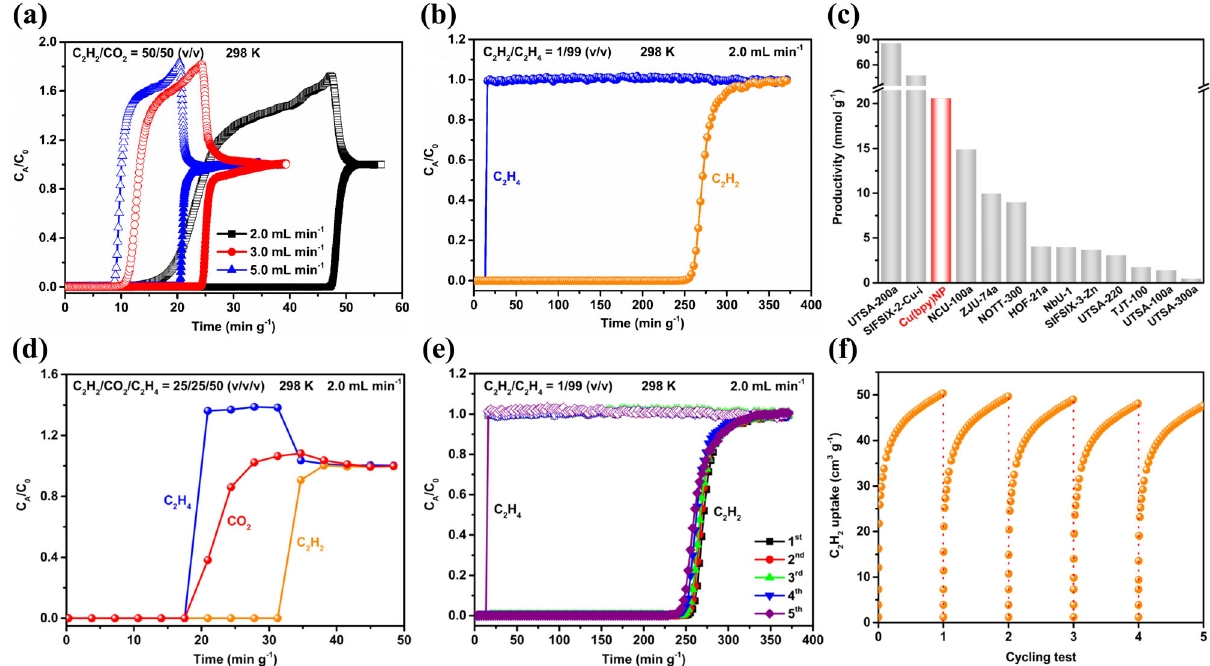
Fig. 3 | C 2 H 2 , CO 2 , and C 2 H 4 separation performances. Dynamic breakthrough curves of Cu(bpy)NP for a C 2 H 2 /CO 2 (50/50, v/v ) and b C 2 H 2 /C 2 H 4 (1/99, v/v ) gas- mixtures; c comparison of C 2 H 4 productivitywithrepresentativeMOFs; d